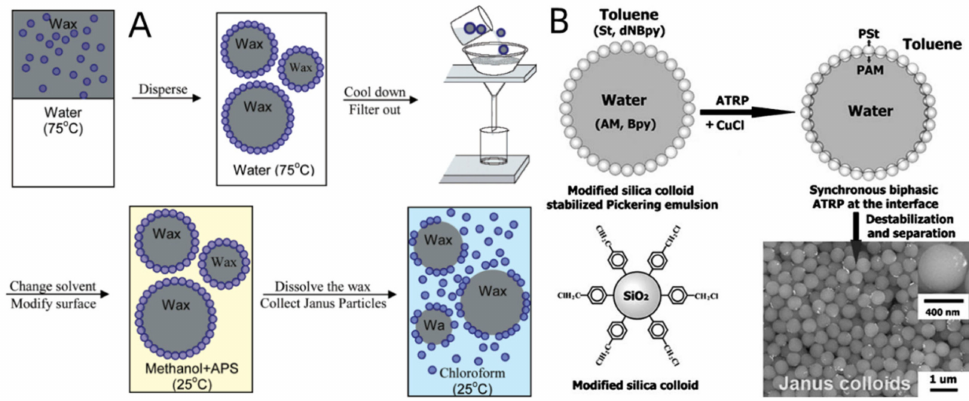
Figure 6. ( A ) Schematic procedure to create Janus particles by functionalizing particles adsorbed onto an emulsion of water and oil and then cooling the sample so that the oil crystallizes to form a wax. Reprinted with permission from ref. [108]. Copyright © 2006 American Chemical Society.